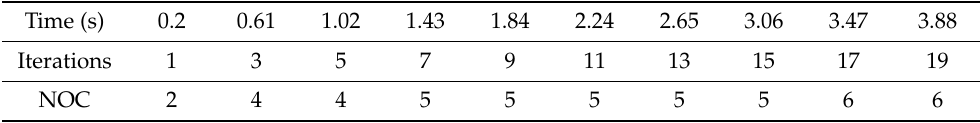
Figure 11. NOC per iteration (BET). Table 8. Number of channels per 10 iterations (BET).